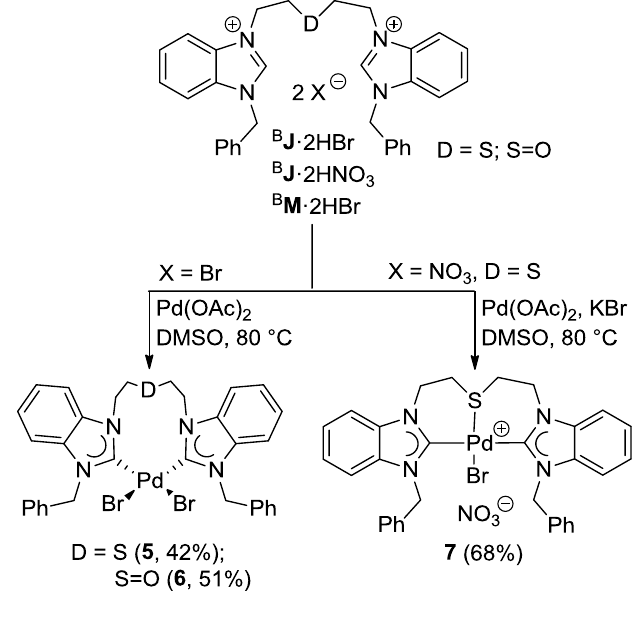
Figure 7. Molecular structures of 5 and 6